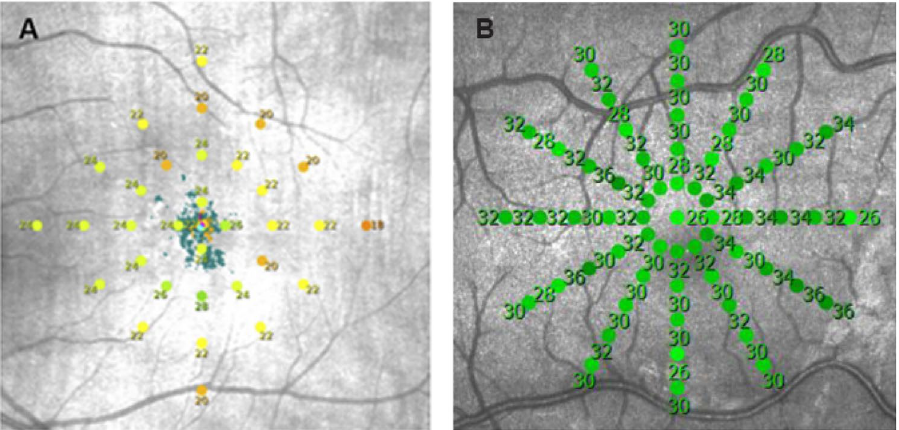
Figure 1. ( A ) Shows the layout of the study custom stimulus grid—33 points located at 0°, 1°, 3°, 5°, and 7° from fixation. ( B ) Shows (in larger magnification) the layout of the grid used by Centervue to create the